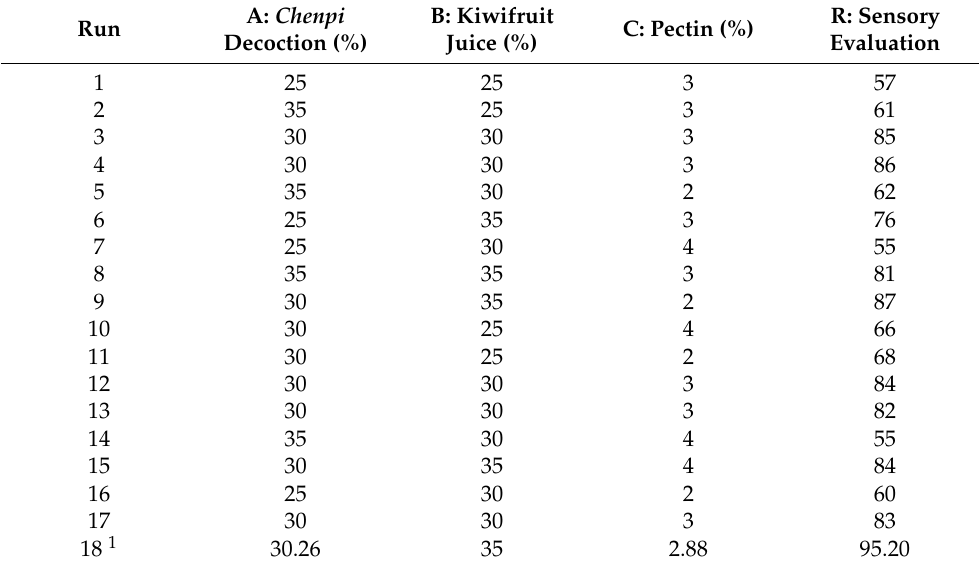
Table 3. Box–Behnken response surface factors and levels.